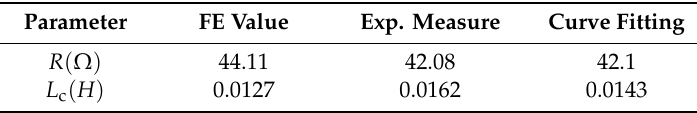
Table 3. EMF model parameter